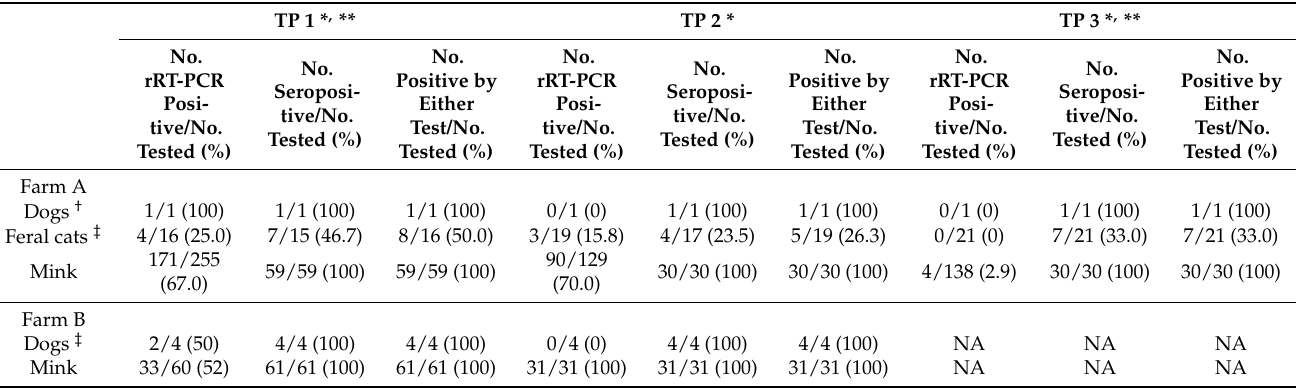
Table 2. Summary of longitudinal animal SARS-CoV-2 rRT-PCR and serology results by farm and species.